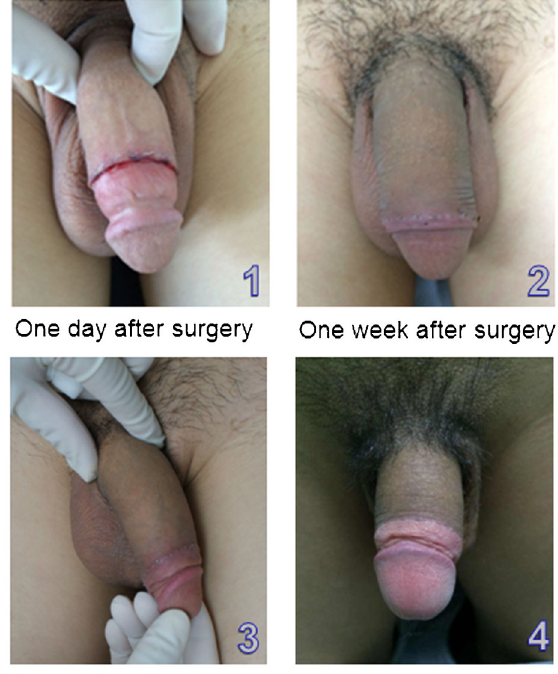
Figure 3. Typical recovery process of stapler